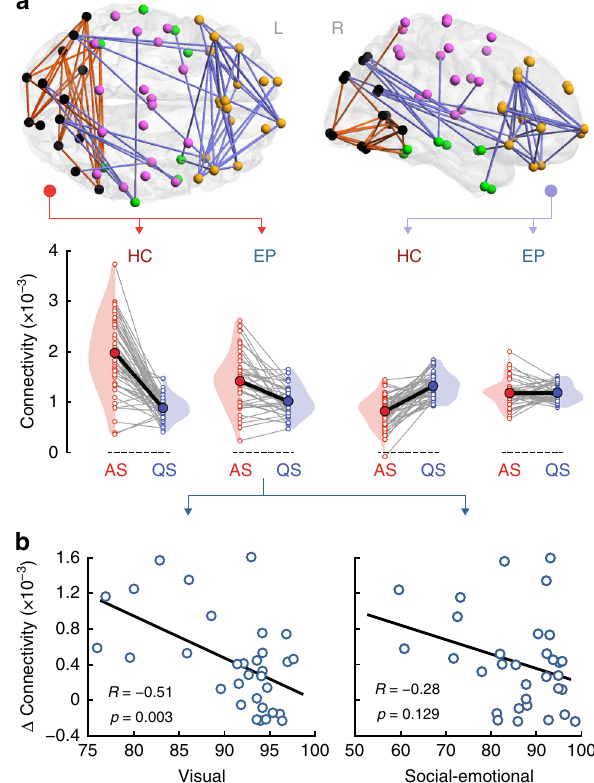
Fig. 4 Alpha-band cortical networks showing a sleep-by-group interaction and their association with neurocognitive outcome at two years. a A positive interaction (changes in connectivity between AS and QS in HC vs. EP) is found for patterns of connectivity linking occipital regions, with only a few connections to temporal and central cortices (orange; p FWER = 0.003, paired two-tailed t -test). This pattern is spatially consistent also across neighboring theta and low beta frequency bands (Supplementary Fig. 2a). A negative interaction (opposite changes in connectivity between AS and QS as a function of group) is observed for long-range connectivity between the frontal cortex and occipital regions (violet; p FWER = 0.0004, paired two- tailed t -test). These interactions re fl ect attenuated changes in connectivity between sleep states in EP compared to HC. Gray lines link individual infants and thick black lines indicate slopes between group means.